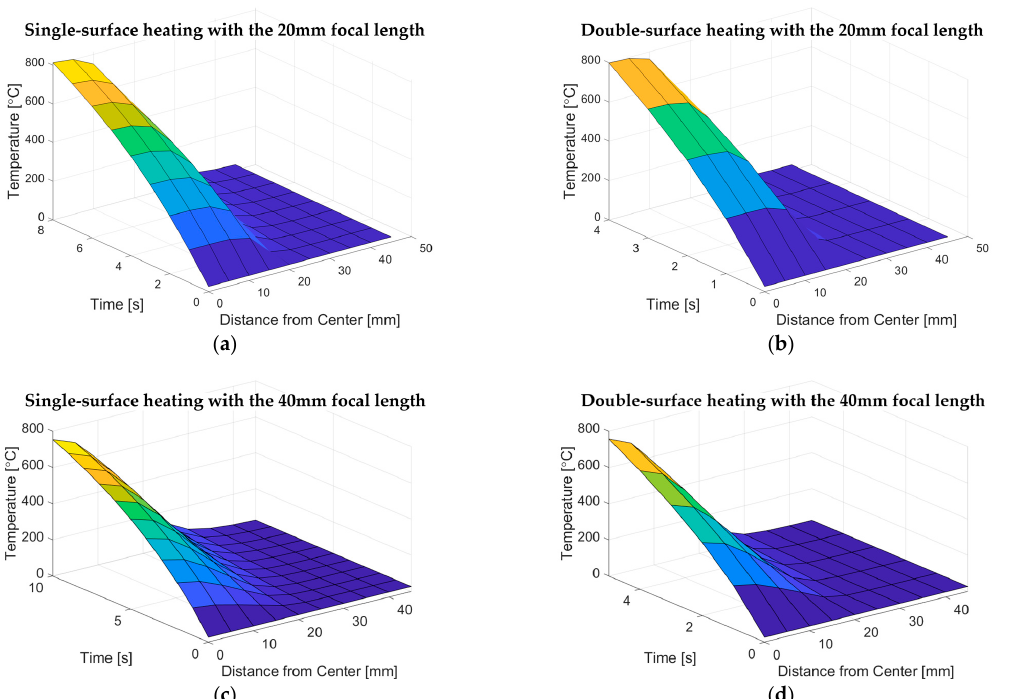
Figure 9. Comparison of the simulation and experiment for the double-surface heating: ( a ) Temperature profile of the target material for the 20 mm focal length; ( b ) Heating rate at the center for the 20 mm focal length; ( c ) Temperature profile of the target material for the 40 mm focal length; ( d ) Heating rate at the center for the 40 mm focal length.